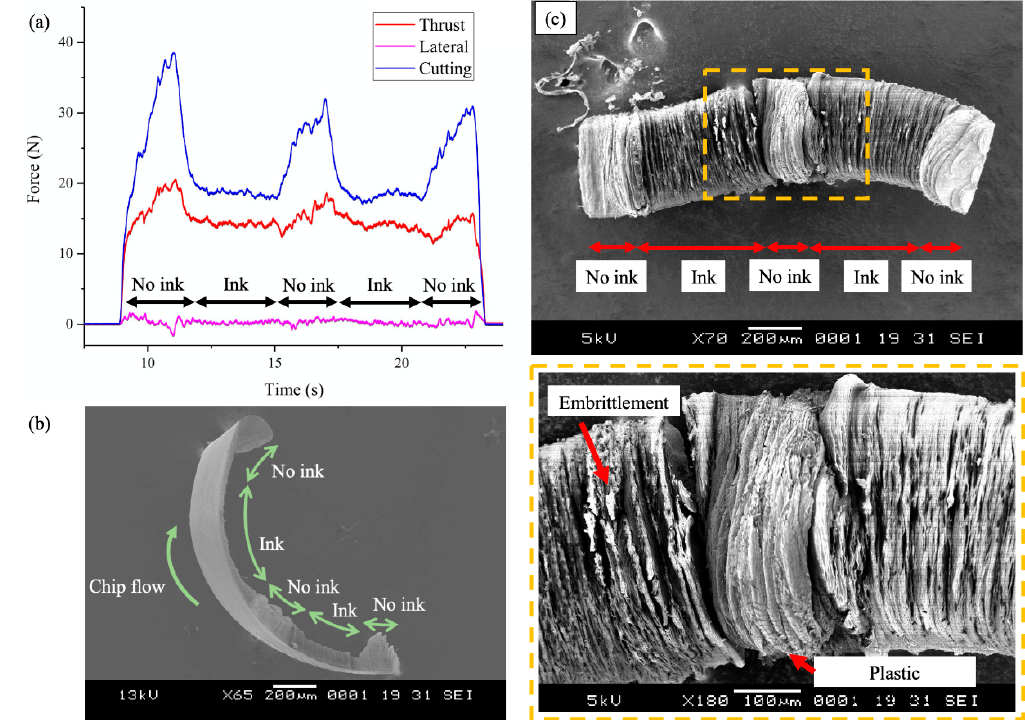
Figure 3. Microgroove chip formation of iron with a cubic boron nitride (CBN) tool at t 0 = 12 μ m and v c = 50 mm/min: ( a ) the measured machining forces; ( b ) the SEM image of chip formation; and ( c ) SEM top view of the chip.